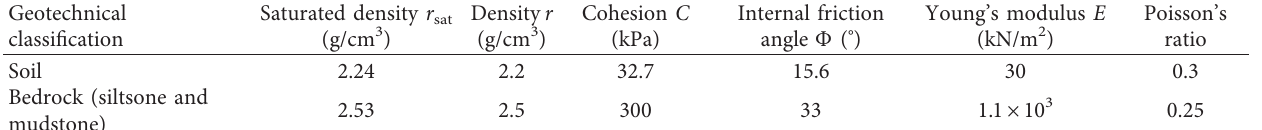
Table 1: Calculation parameters of geotechnical materials for the landslide.